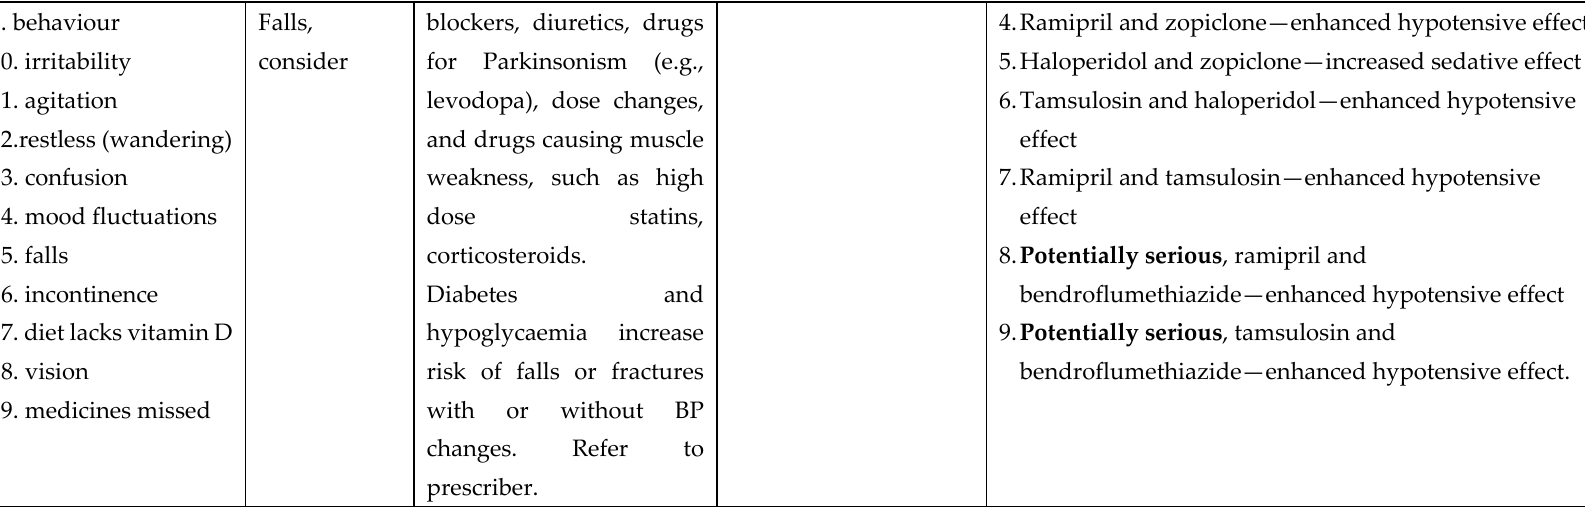
Figure 2. ADRe in action: preventing falls. ADRe: the adverse drug reaction profile, N.B. Medicines relevant to the resident are emboldened in the supporting information, BP = blood pressure, o.d. = omni die (every day).